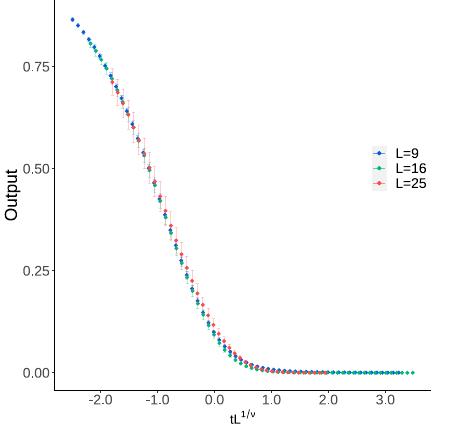
Figure 20: q = 2: The finite-size scaled plot of the average output of an ensem- ble of 10 independently trained ANNs – training with MC data of the ferromagnetic square-lattice Ising model, and testing with MC data of the ferromagnetic 2-state Potts model on a cubic lattice. The error bars shown are 99.7% confidence intervals of the ensemble average.